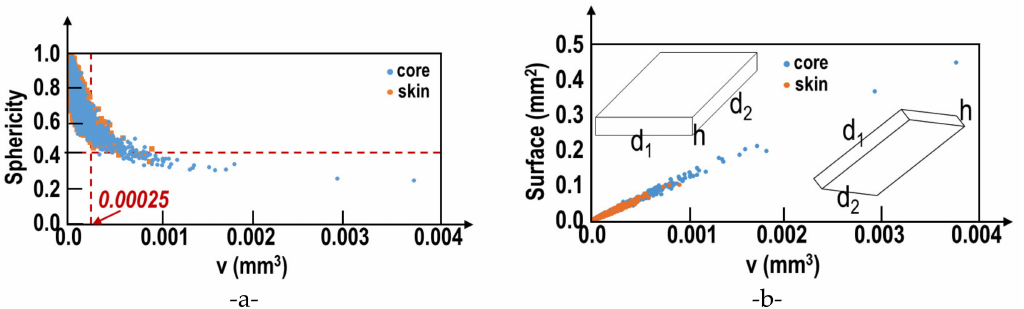
Figure 8. Micro-shrinkage characterization. ( a ) Sphericity in function of the volume v, and ( b ) total surface in function of the volume